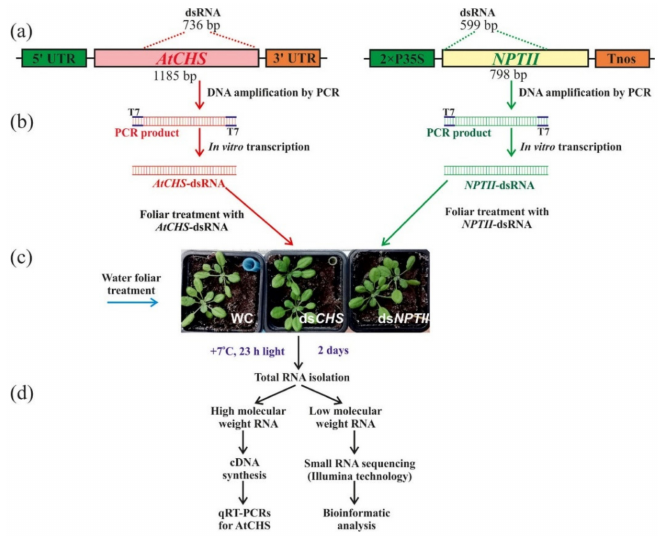
Figure 1. Schematic representation of the experiment conducted in the study to verify the effects of external dsRNA treatments in Arabidopsis thaliana on small RNAs profiles and AtCHS gene ex- pression. ( a ) Representation of AtCHS- and NPTII -coding regions with positions of the AtCHS - and NPTII -specific dsRNA; ( b ) PCRs with the T7 promoter appended to both PCR primers for AtCHS and NPTII partial amplification, followed by in vitro dsRNA production; ( c ) plant foliar treatments with AtCHS - and NPTII -specific dsRNA; ( d ) low- and high-molecular-weight RNA isolation and processing. 2xP35S—the double 35S promoter of the cauliflower mosaic virus (CaMV); AtCHS —the chalcone synthase gene from A. thaliana ; NPTII —the neomycin phosphotransferase II ( NPTII ) gene; Tnos—nopaline synthase terminator. T7–T7